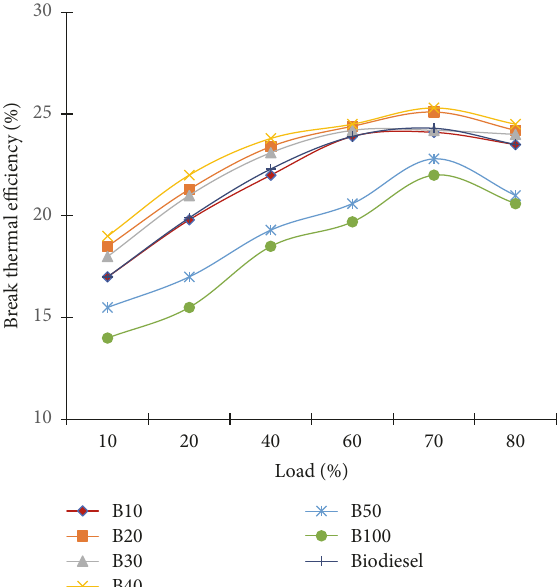
Figure 10: Brake thermal efficiency for different